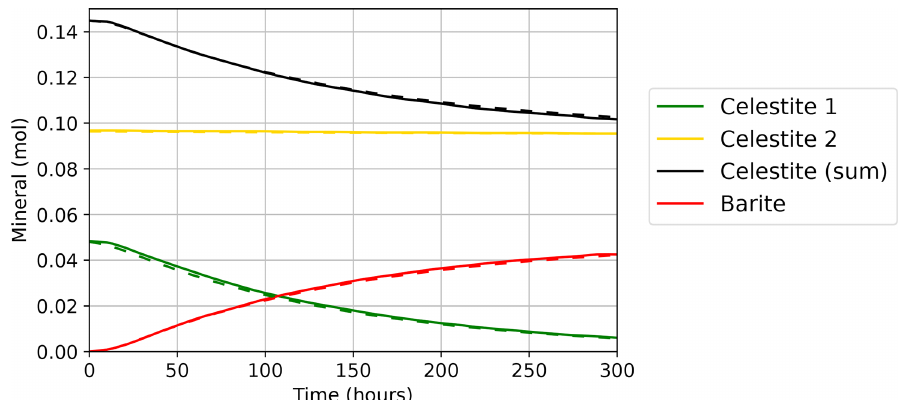
Figure 8. Temporal development of the mineral composition in the flow cell calculated by TRANSPORTSE-PHREEQC (dashed lines) in comparison against the results documented by Poonoosamy et al. (2021) (solid